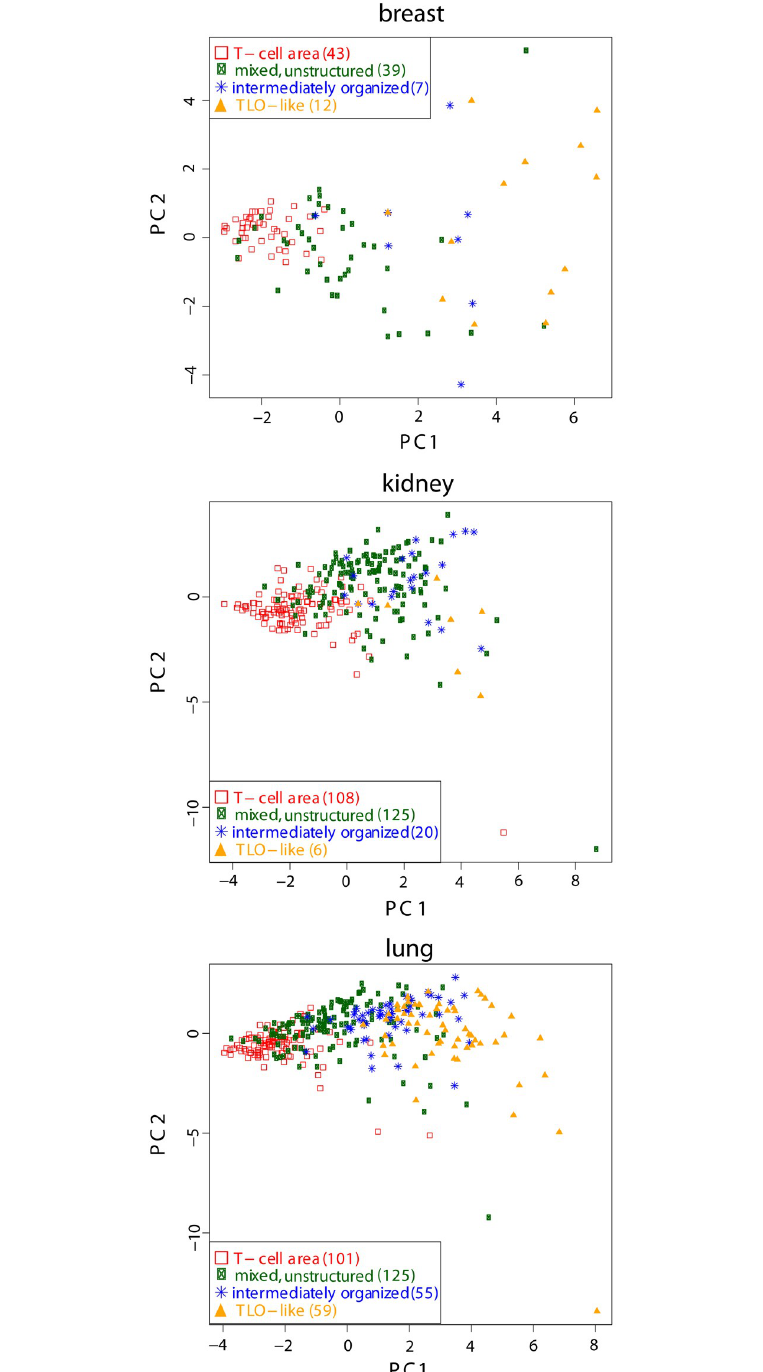
Fig 4. Principal component analysis between components with highest variance (PC1, PC2) for 700 samples in total (number of each class and tissue type listed in legend as brackets) that were visually classified by a pathologist. The number of nodes (| V |, V B |/| V |), edges (| E |, j E j = j E j ), TLO-like organization ( κ (2), κ (5)), a B homogeneity ( H ), clustering coefficient ( C ), average degree ( h K i ), and the average Euclidean distance between all nodes are used as features, see Section Features of infiltrates.